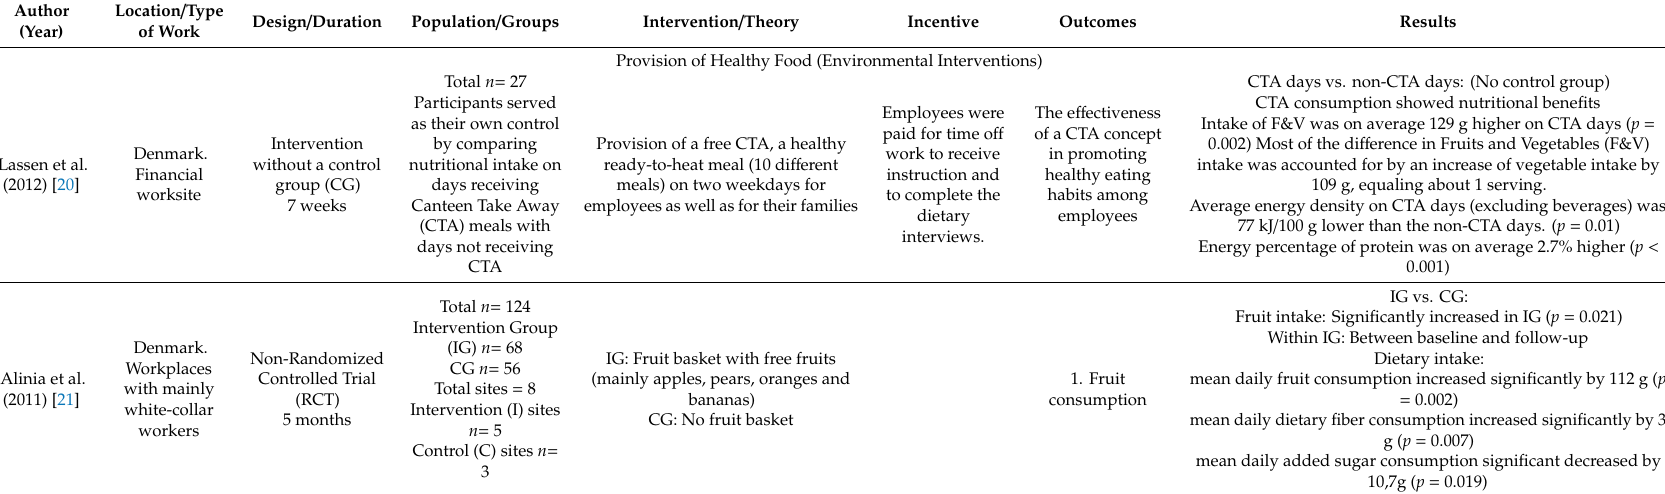
Table 2. Summary of the studies focusing on the provision of healthy food listed by author and year, the study design, duration, sample size, intervention type, intervention, incentive, outcome measures, and main